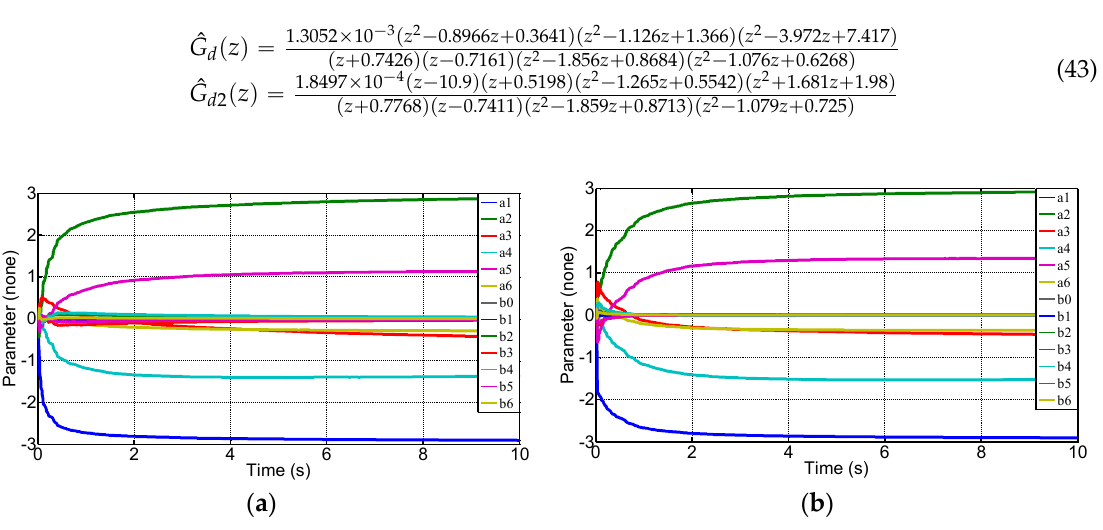
table; ( b ) 2#_shaking table.